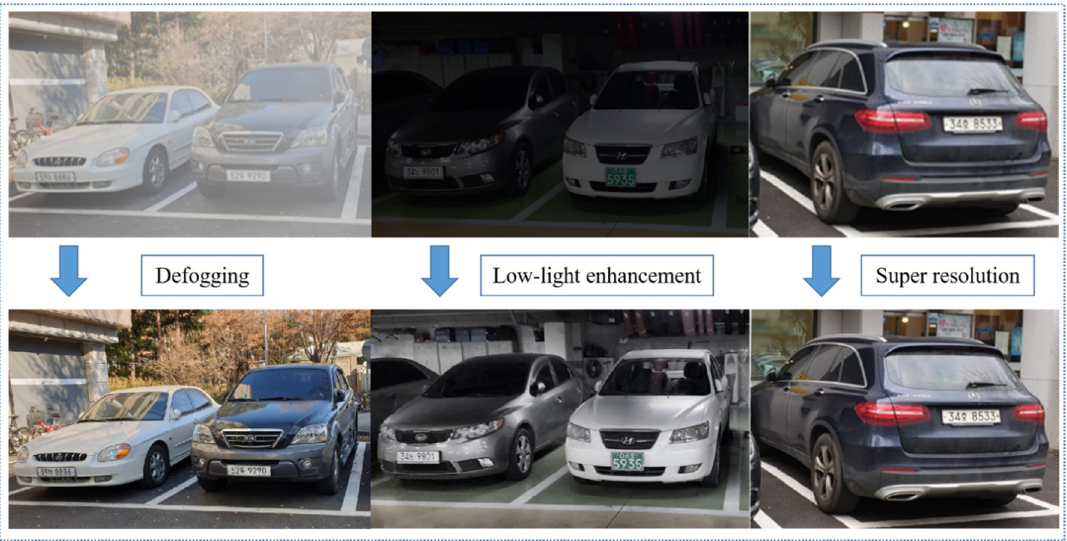
Figure 6. The visual effect of three image preprocessing technologies, which include defogging, low-light enhancement, and super-resolution.